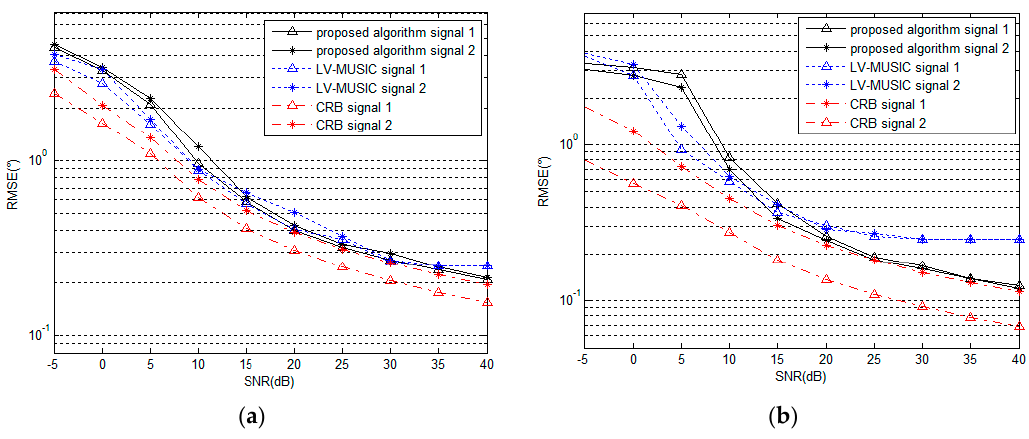
Figure 8. RMSE of ( a ) azimuth angle and ( b ) elevation angle estimation versus SNR (for 200 snapshots).